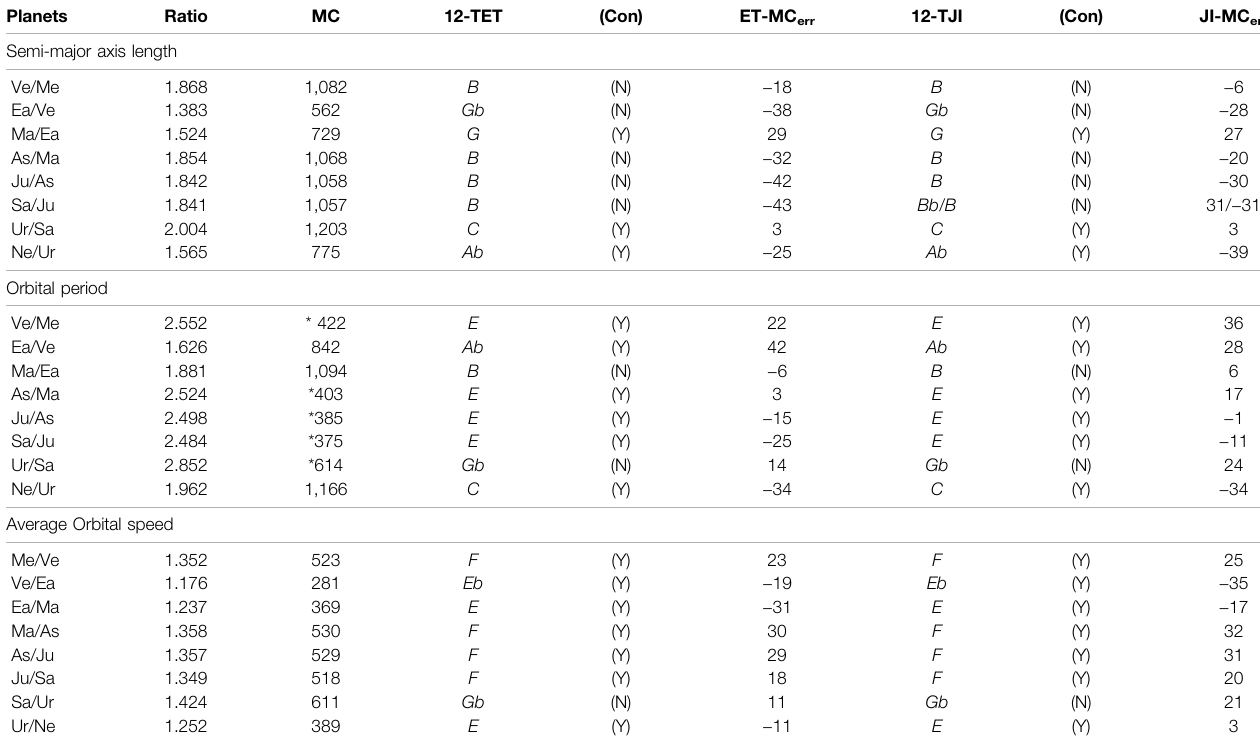
TABLE 3 | Musical tones in the semi-major axis, orbital period, average speed ratios of adjacent planets. The columns indicate: the adjacent planet couples; the orbital parameterratio;itsvalueinmusicalcents(MC),thesymbol(*)indicatesthattheMCvalueisreducedby1,200cents;12-TETistheclosesttone(fortheinnerplanetofthe pairwhentheouterplanetistunedto C )accordingtotheexact12-TETsystemwiththeYes/Noconsonanceproperty(Con);ET-MC err istherelativeerror;12-TJIandJI-MC err are equivalent but relative to the 12 tones of the just-intonation 12-TJI system. (Refer to Table 1 for the numerical values of the tones).